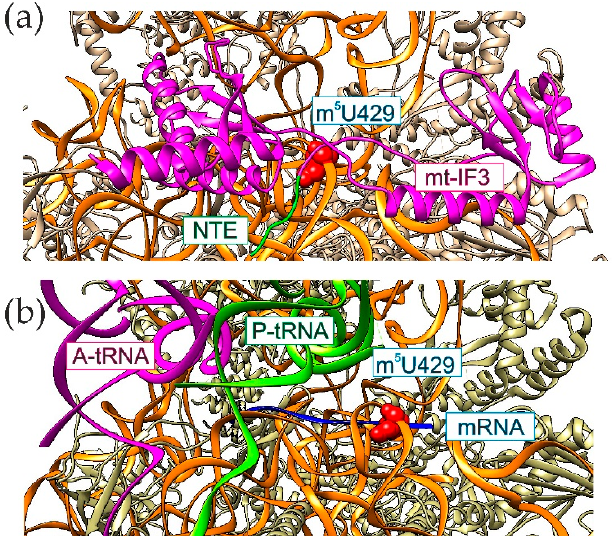
Figure 3. Location of the methylated nucleotide m 5 U429 of the 12S rRNA (red spacefilled object) relative to the ligands of the small subunit of mitochondrial ribosome. ( a ) tertiary structure of mt-IF3 complex with the 28S subunit [135]. mt-IF3 is shown as pink ribbon, while its mitochondria-specific N-terminal extension is shown as green ribbon. ( b ) tertiary structure of the mammalian mitochondrial ribosome complex with mRNA and tRNAs [69]. Color scheme is the same as for the Figure 2. UCSF Chimera [36] was used to create this illustration.